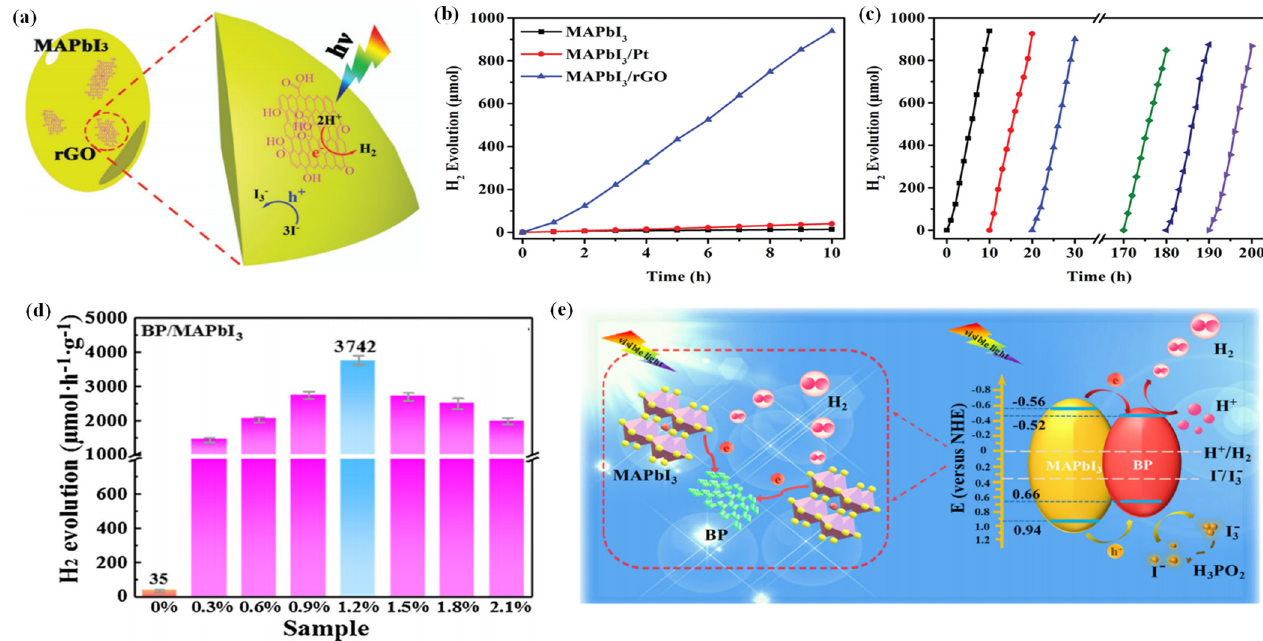
Figure 4. ( a ) Schematic illustration of photocatalytic H 2 evolution by MAPbI 3 /rGO. ( b ) Comparison of the H 2 evolution performance of MAPbI 3 , MAPbI 3 /Pt, and MAPbI 3 /rGO. ( c ) Stability test of MAPbI 3 /rGO during 20 cycles of H 2 evolution experiments. Lines with different colors represent different cycles. ( d ) Photocatalytic H 2 evolution rates of BP/MAPbI 3 . ( e ) Schematic mechanism of the photogenerated charge transfer in the BP/MAPbI 3 composite under visible light irradiation. ( a – c ) Re- produced with permission [41]. Copyright: 2018, Wiley. ( d , e ) Reproduced with permission [114]. Copyright: 2019,